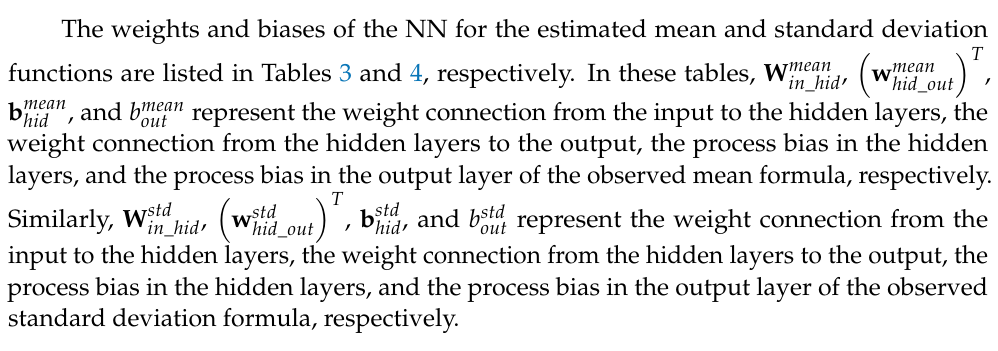
Table 3. Weight and bias terms of the NN for the estimated process mean.